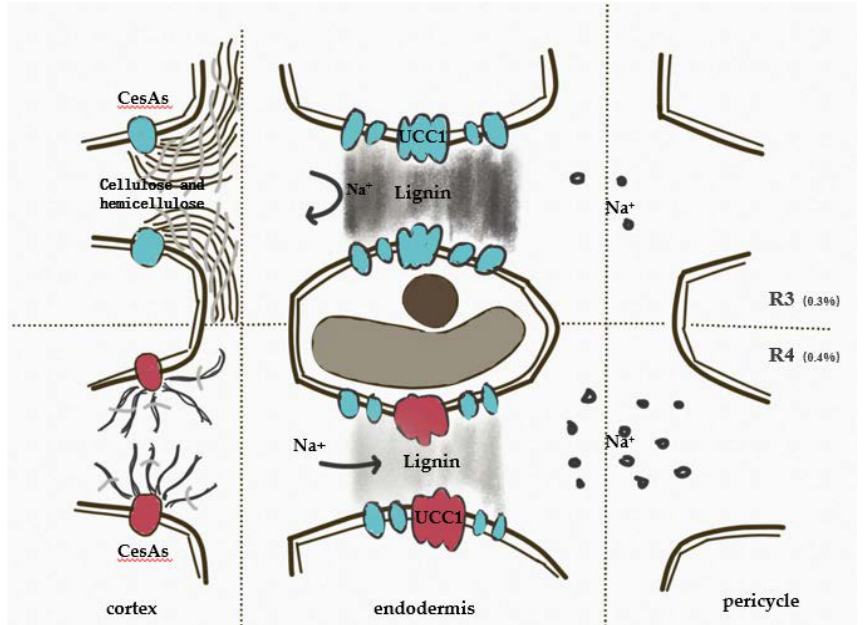
Figure 10. Assembly of Casparian strip under salt stress. Protein stained green indicate stable expression compared with the control, while red indicates significantly down-regulated expression compared with the control. The down-regulation of UCC1 in R4 decreased lignin deposition in the central microregion of the Casparian strip.